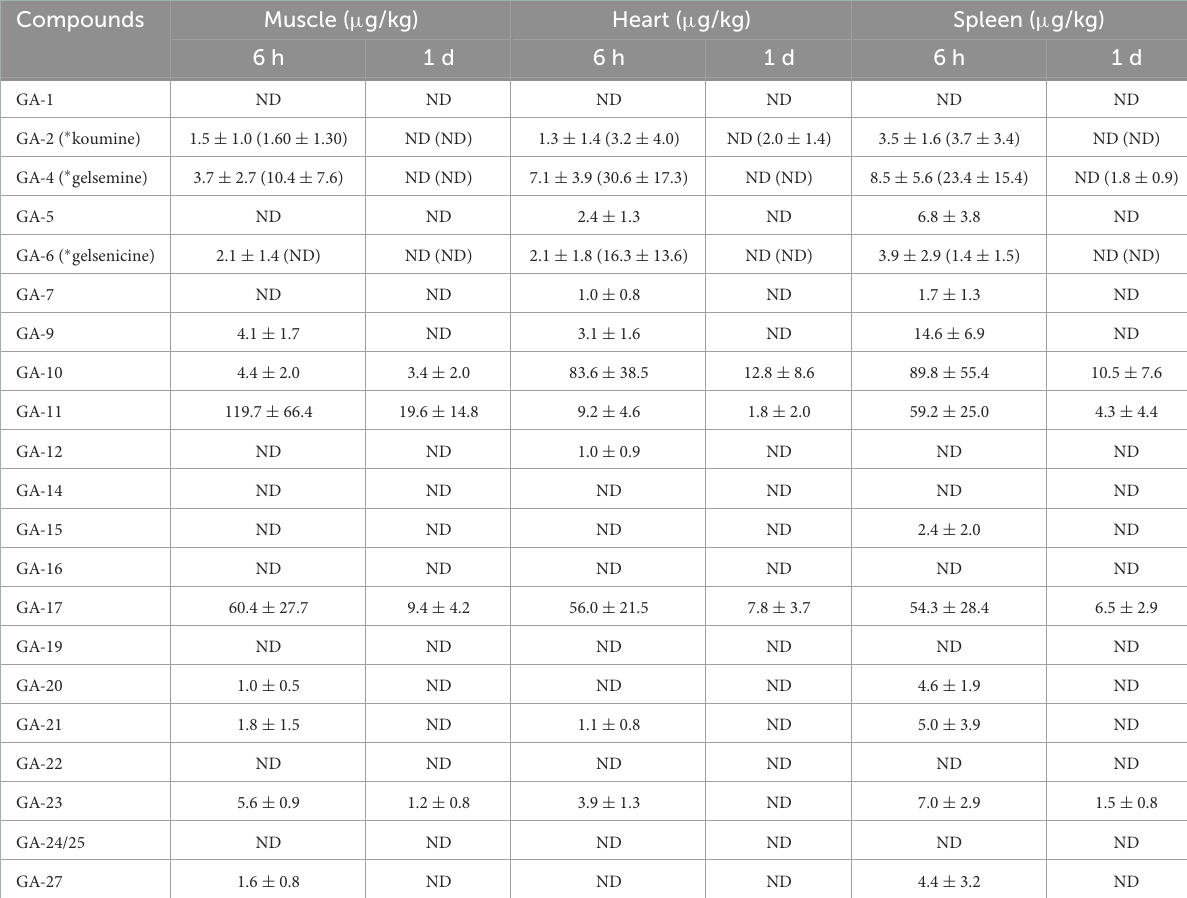
TABLE 2 Concentrations of Gelsemium alkaloids in pig muscle, heart, and spleen after 45 d of consecutive administered G. elegans powder at a dose of 2% per kilogram feed ( µ g/kg) ( n = 5).